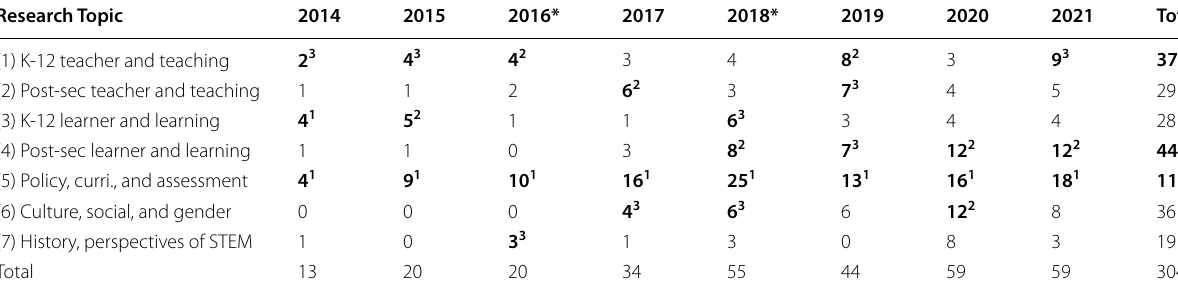
1 Number one topic, 2 Number two topic, 3 Number three topic *Excluding errata from that year’s publications